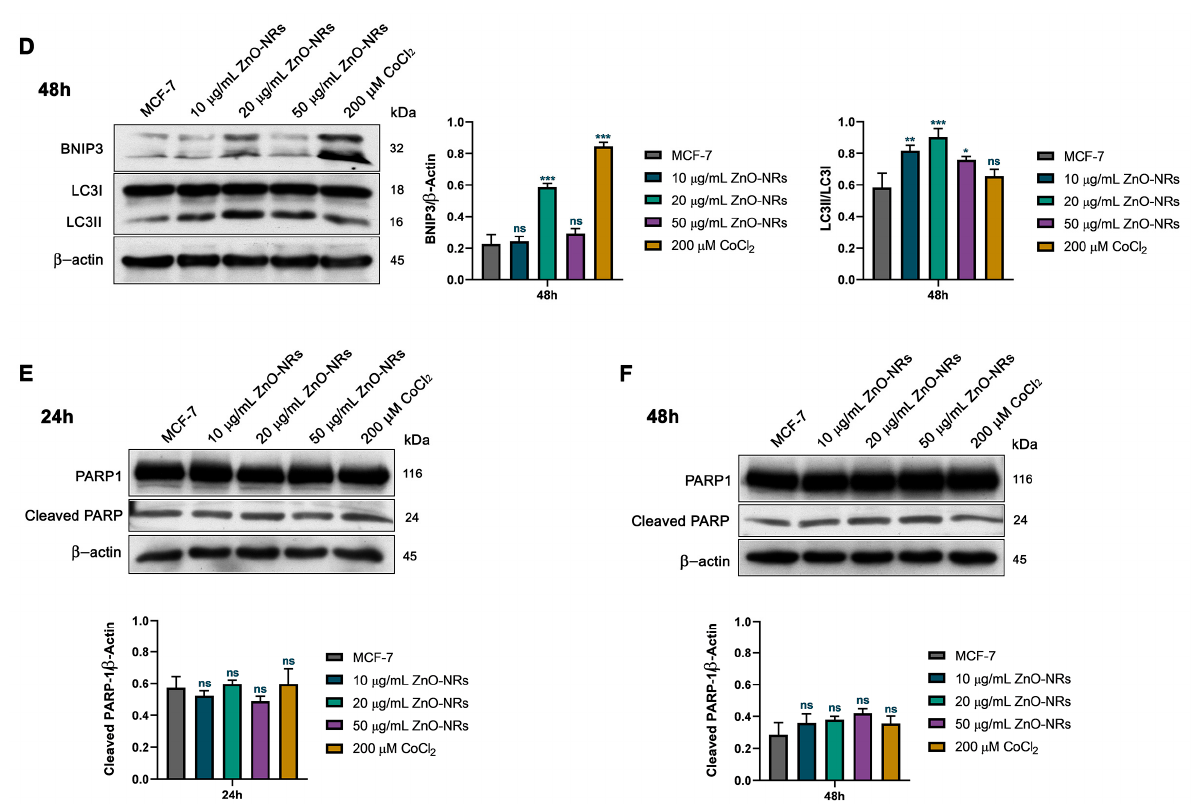
Figure 9. ZnO-NRs’ effects on autophagy and mitophagy in MCF-7 cells. MCF-7 cells were either untreated or treated with the indicated ZnO-NR concentration for 24 and 48 h. ( A ) BNIP3, LC3I, and LC3II expression after 24 h treatment with 10, 20, and 50 µ g/mL ZnO-NRs. Right side, densitometric analysis of BNIP3 and LC3II protein expression. ( B ) TEM images of MCF-7 cells treated with 50 µ g/mL ZnO-NRs for 24 h showing the presence of mitophagic vacuoles (black arrows). Size bars, 0.5 µ m. ( C ) TEM image of MCF-7 cells treated with 50 µ g/mL ZnO-NRs for 24 h showing the presence of autophagic vacuoles (black arrows). Size bars, 0.5 µ m. ( D ) BNIP3, LC3I, and LC3II expression after 48 h treatment with 10, 20, and 50 µ g/mL ZnO-NRs. Right side, densitometric analysis of BNIP3 and LC3II protein expression. ( E , F ) PARP1 and cleaved PARP expression after 24 and 48 h treatment with 10, 20, and 50 µ g/mL ZnO-NRs. Densitometric analysis is reported below each blot. Experiments were repeated three times. * p < 0.05, ** p < 0.01, and *** p < 0.001. ns, not significant. In all experiments, hypoxia, induced by 200 µ M CoCl 2 , was used as positive control. β -actin was used as loading